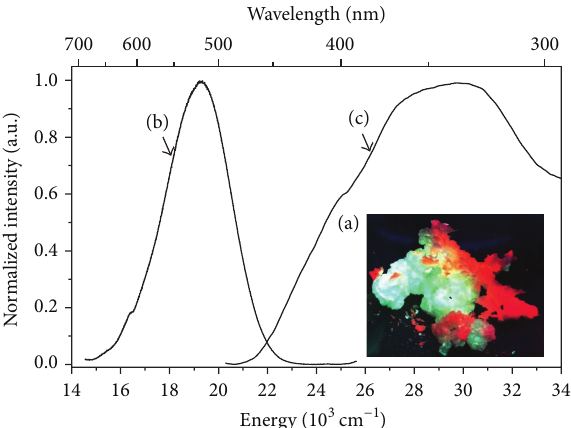
= 22 em transitions. J